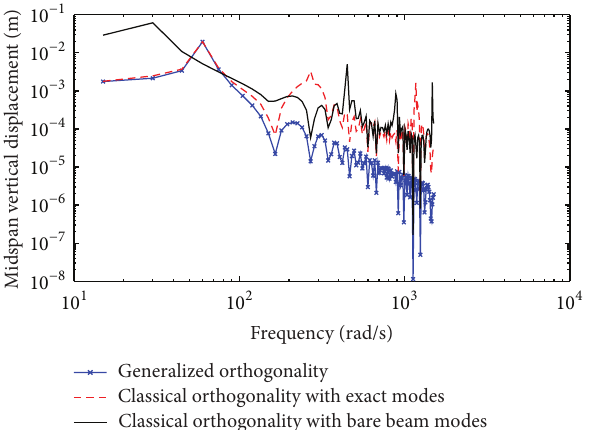
Figure 10: Frequency response of a simply supported beam carrying one in-span mass-spring-damper-mass system for 𝑘 = 190428 N/m, = 3.0775 kg, 𝑀 = 0 kg, 𝑇 = 0 N, 𝐸𝐼 = 63476.1 Nm 2 , 𝑐 𝑀 𝑑 𝑐 = 0.75 m. 100 Ns/m, and 𝐿 𝑑